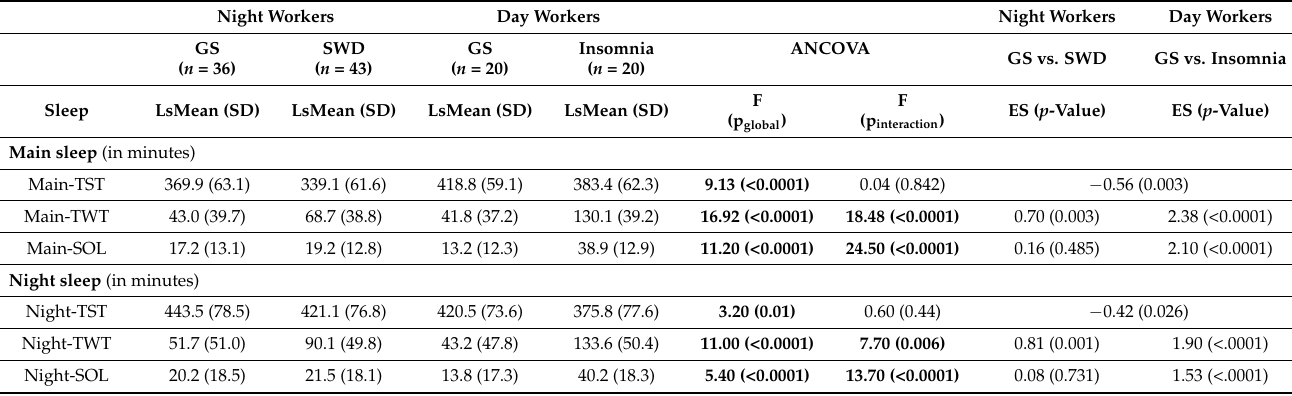
Table 3. LsMean for sleep variables according to Work schedule (night or day workers) and sleep disorder (good sleep or